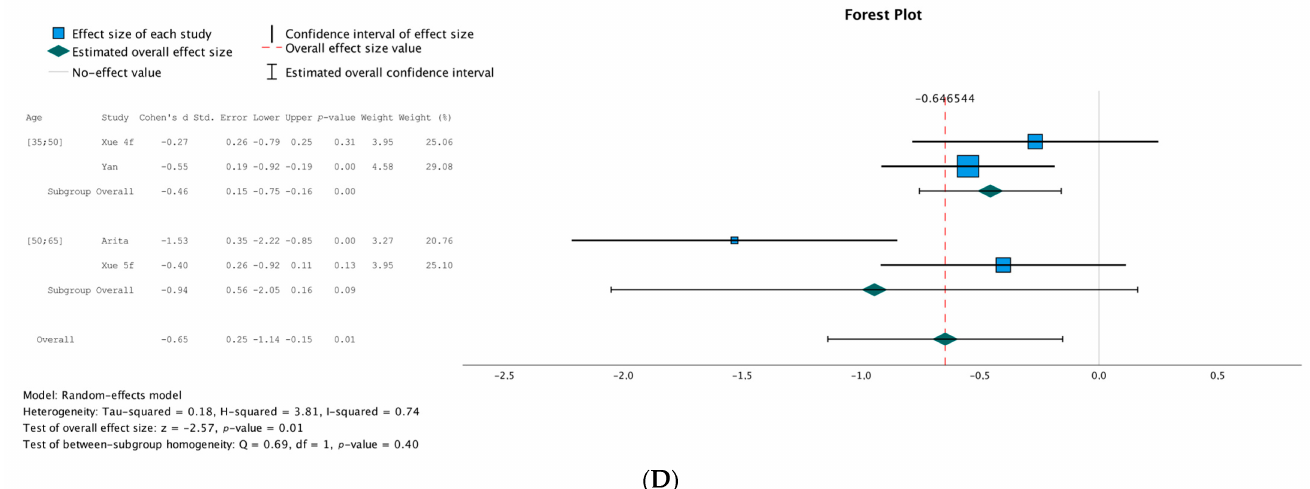
Figure 3. Legend: std = standard, 4f = 4 flashes, 5f = 5 flashes. ( A ). NIBUT: changes from baseline between groups, forest plot. ( B ). TBUT: changes from baseline between groups, forest plot. ( C ). OSDI: changes from baseline between groups, forest plot. ( D ). SPEED: changes from baseline between groups, forest plot